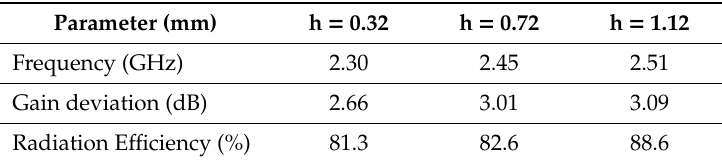
Table 2. Final design parameters of the proposed quasi-isotropic antenna design.